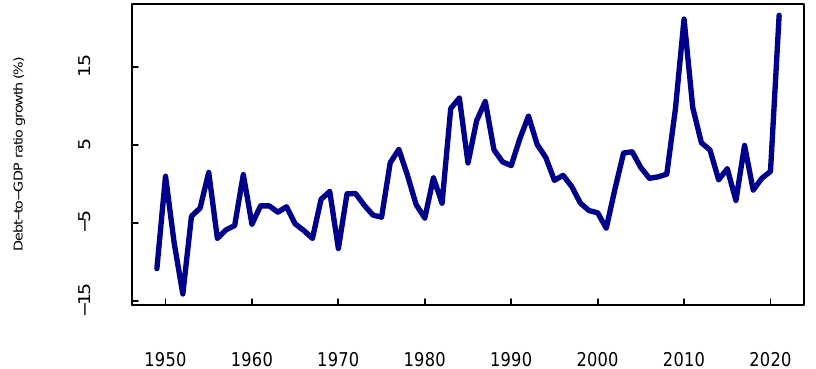
Figure 1. The United States annual debt-to-GDP ratio % growth (dark blue line), calculated using the annual gross federal debt as percent of gross domestic product [16]. The sample period is